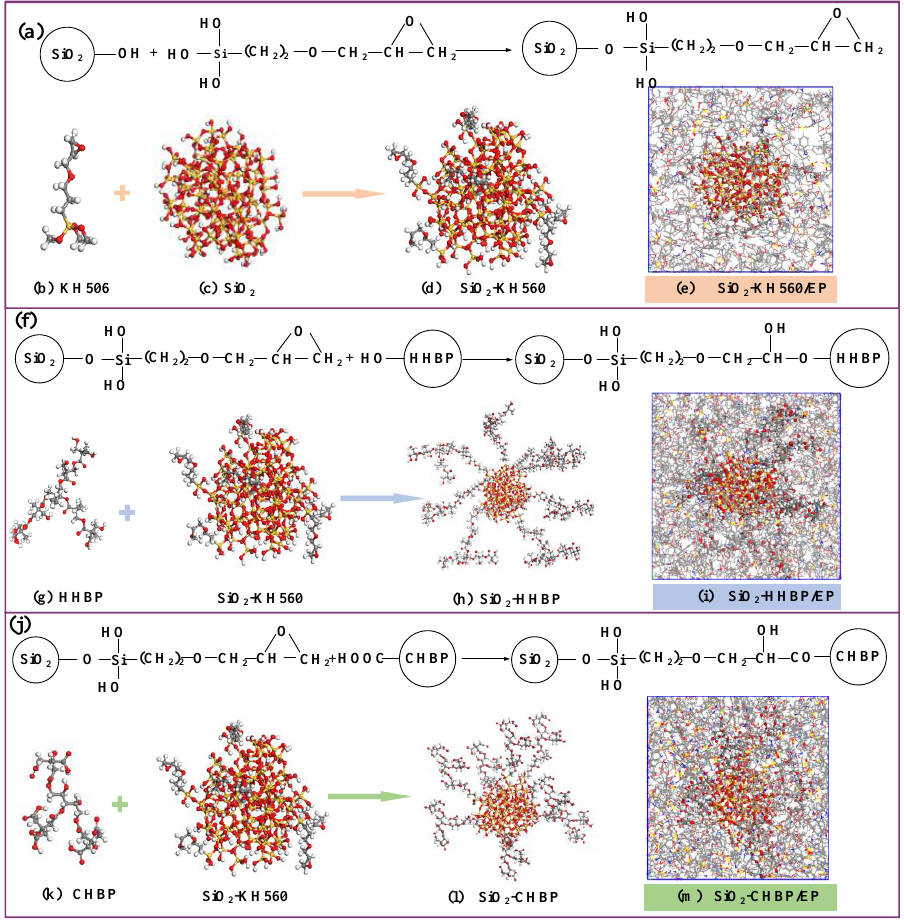
Figure 3. ( a ) Reactions of grafting KH560; ( b ) KH560; ( c ) silica particle; ( d ) silica particle with KH560; ( e ) epoxy composite containing silica particles grafted with KH560; ( f ) reactions of grafting HHBP; ( g ) HHBP; ( h ) silica particle grafted with HHBP; ( i ) epoxy composite containing silica particles grafted with HHBP; ( j ) reactions of grafting CHBP; ( k ) CHBP; ( l ) silica particle grafted with CHBP; ( m ) epoxy composite containing silica particles grafted with CHBP.